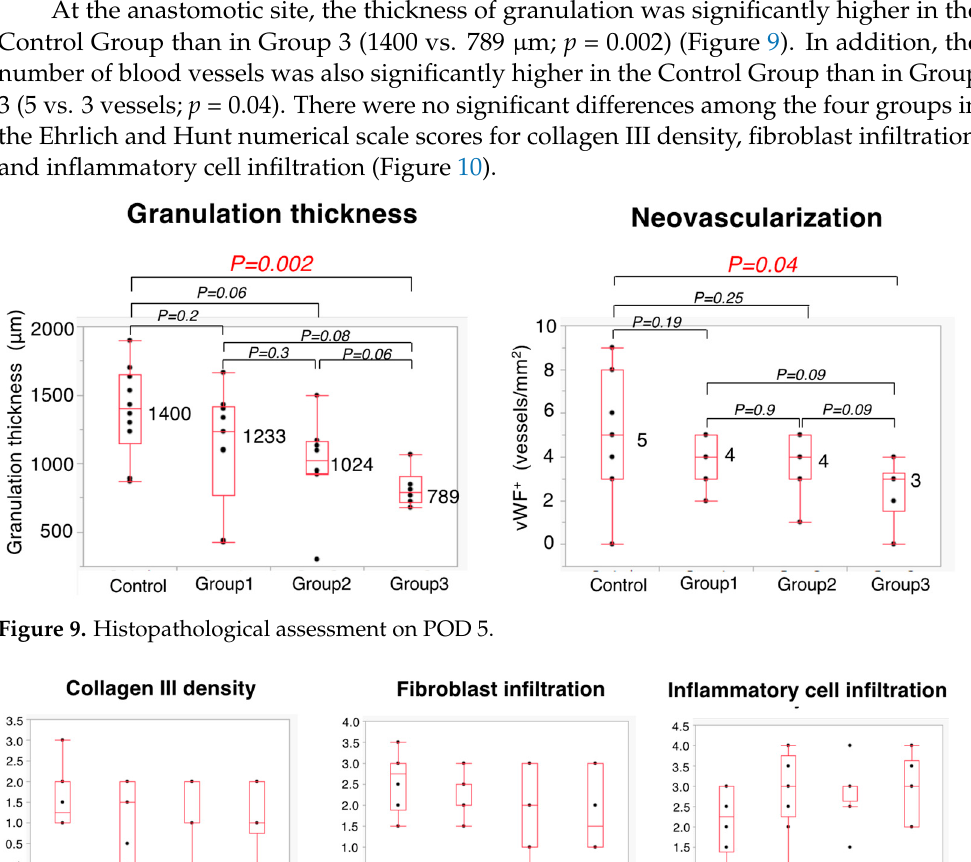
Figure 8. Relationship between five ICG fluorescence-related parameters and bursting pressure.